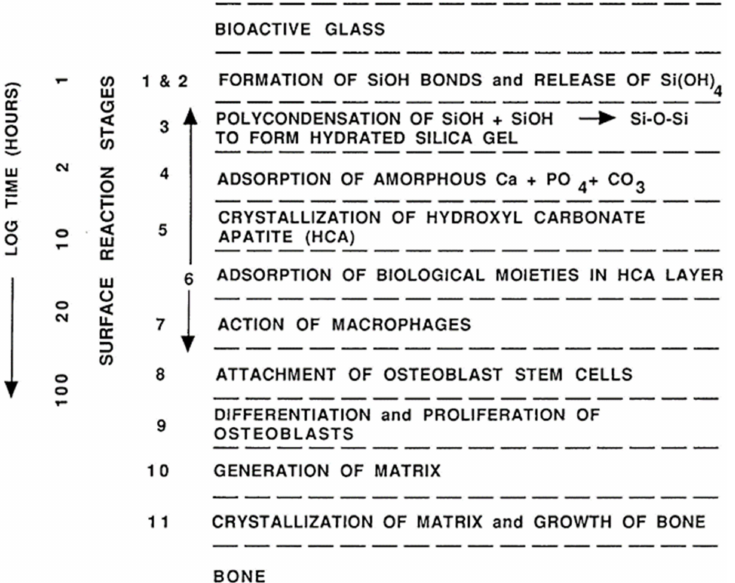
Figure 12. A sequence of interfacial reactions involved in forming a bond between tissue and bioactive ceramics. Reprinted from Refs. [50,51] with